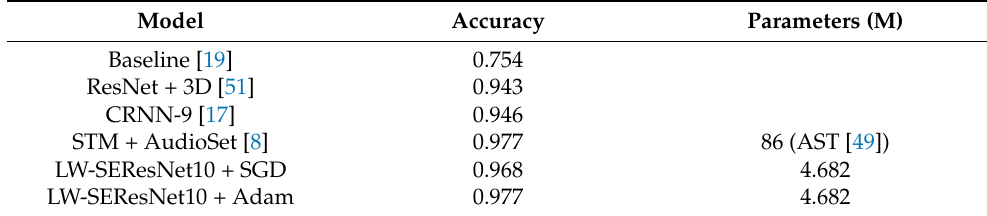
Table 8. The accuracy and parameters of different models.